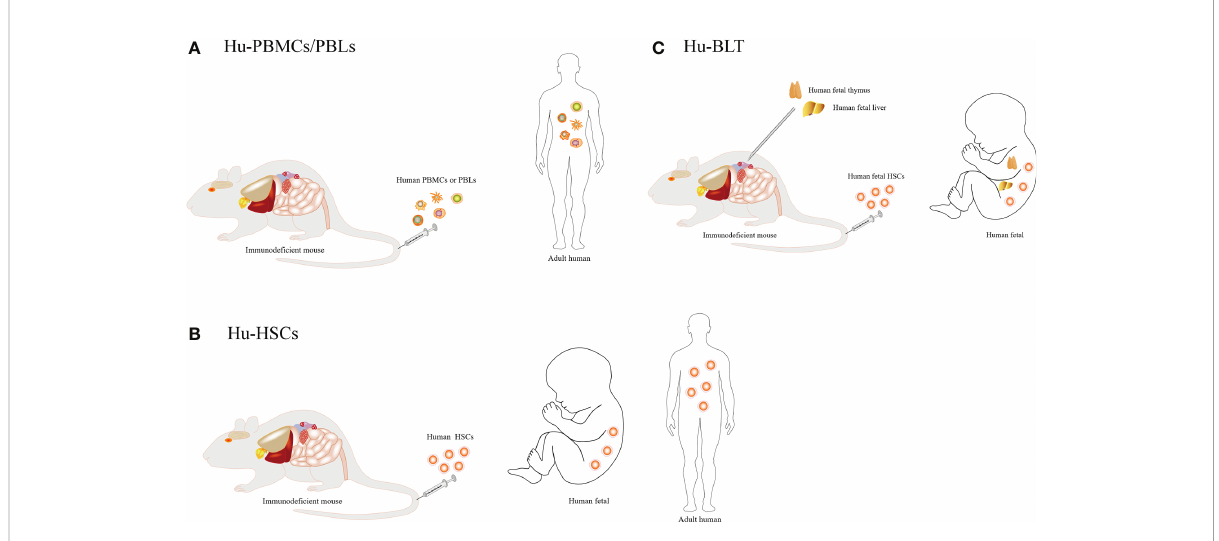
FIGURE 2 Different construction methods of humanized mice. (A) Injection of human peripheral blood mononuclear cells or lymphocytes. (B) Injection of